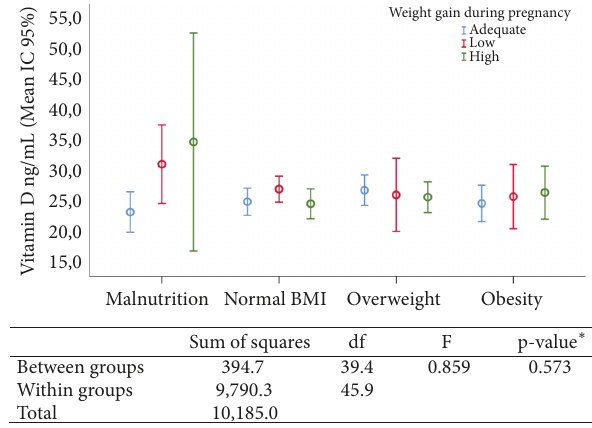
Figure 1: Mean of 25(OH)D concentrations concerning the mater- nal nutritional status before and gestational weight